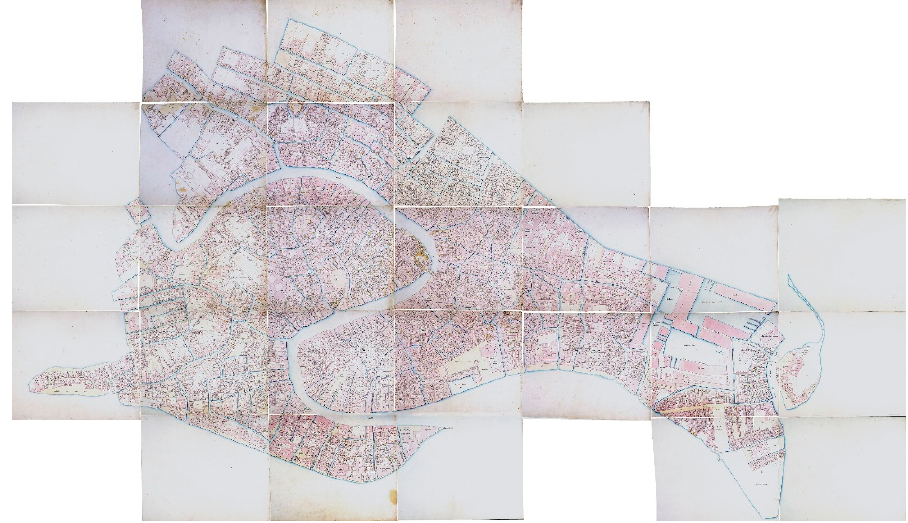
Figure 3. The mosaic of the sheets composing the Napoleonic cadastre correctly georeferenced.